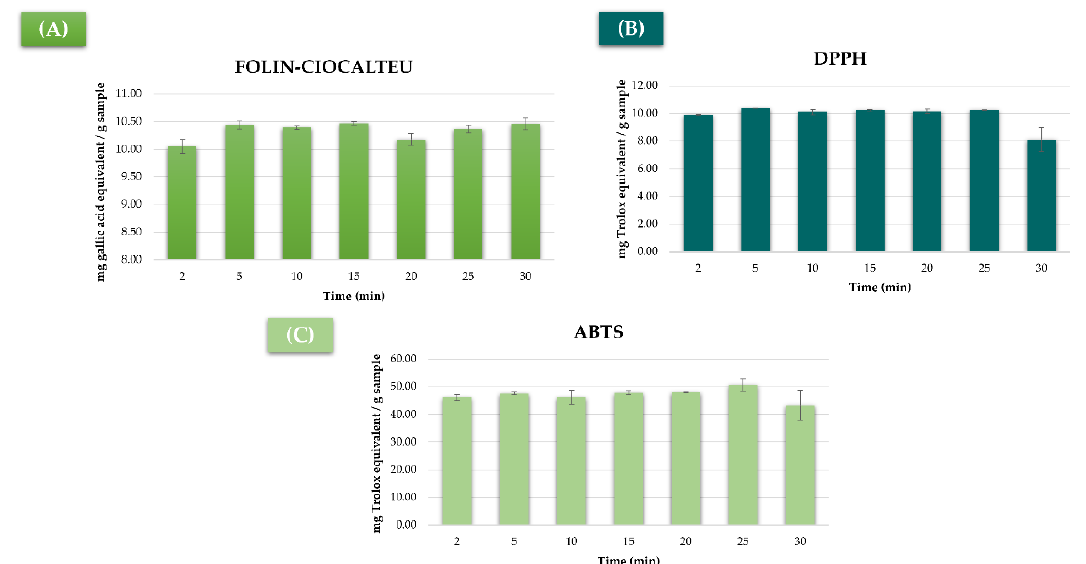
Figure 7. Mushroom samples extracted ( n = 3) under global optimum conditions using different extraction times and analyzed by ( A ) Folin–Ciocalteu (milligrams of gallic acid equivalent/gram of sample), ( B ) DPPH method (milligrams of Trolox equivalent/gram of sample), and ( C ) ABTS method (milligrams of Trolox equivalent/gram of sample).